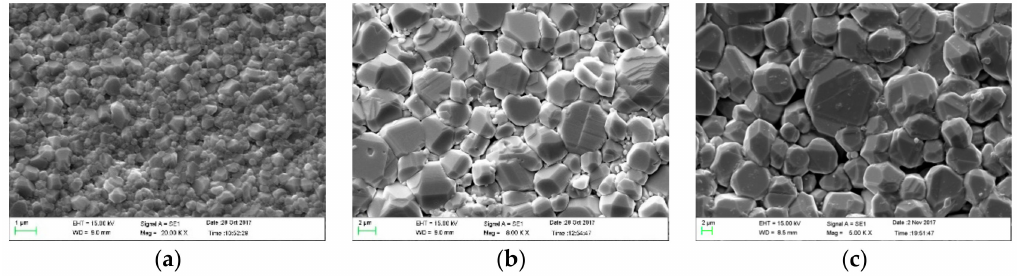
Figure 2. SEM images of polished and thermally etched surfaces of BM1T sintered at T s = ( a ) 1200, ( b ) 1300, and ( c ) 1400 ◦ C. XRD patterns of nominal (Ba 1 − x Mg x )TiO 3 ( x = 0.015-0.20) (BMT) ceramics sintered at T s = 1200